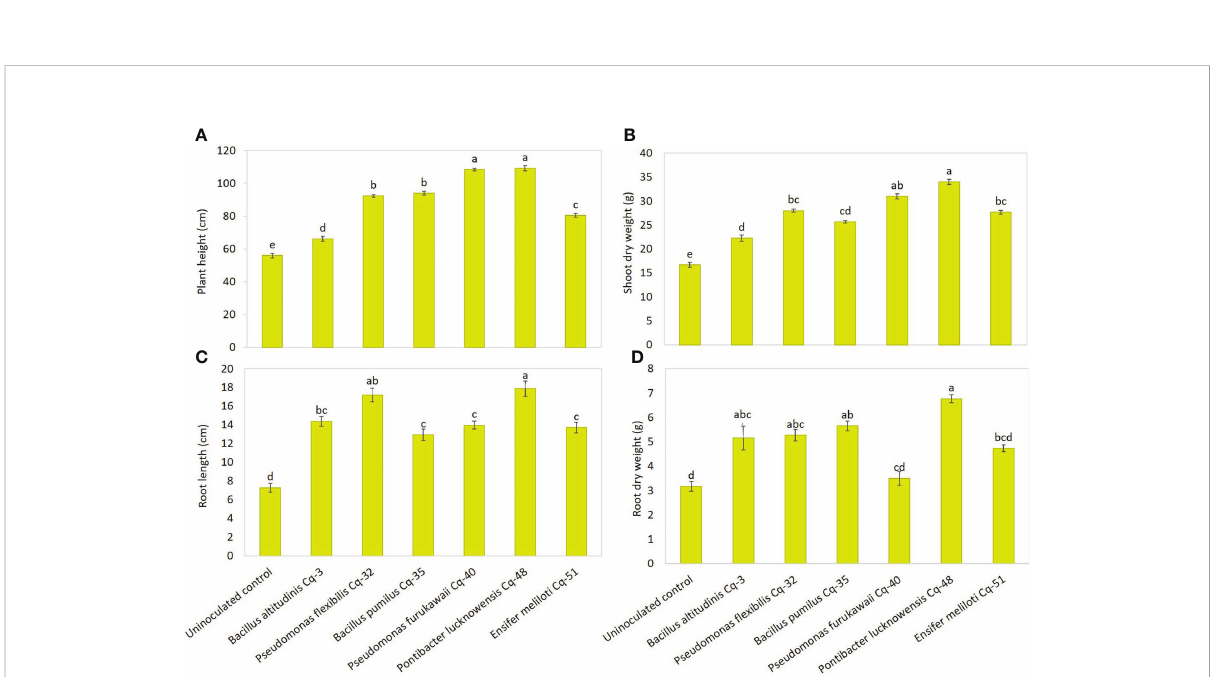
FIGURE 5 Effect of phosphate-solubilizing bacterial strains on quinoa growth attributes in fi eld conditions; growth attributes were recorded in terms of plant height (A) , shoot dry weight (B) , root length (C) , and root dry weight (D) ; the control had no inoculum (uninoculated control) and contains only broth; data presented are the mean of three replications along with standard error; the means sharing common letters were considered statistical similar to each other, and least signi fi cant difference (LSD) test was performed at 5% ( P ≤ 0.05) probability